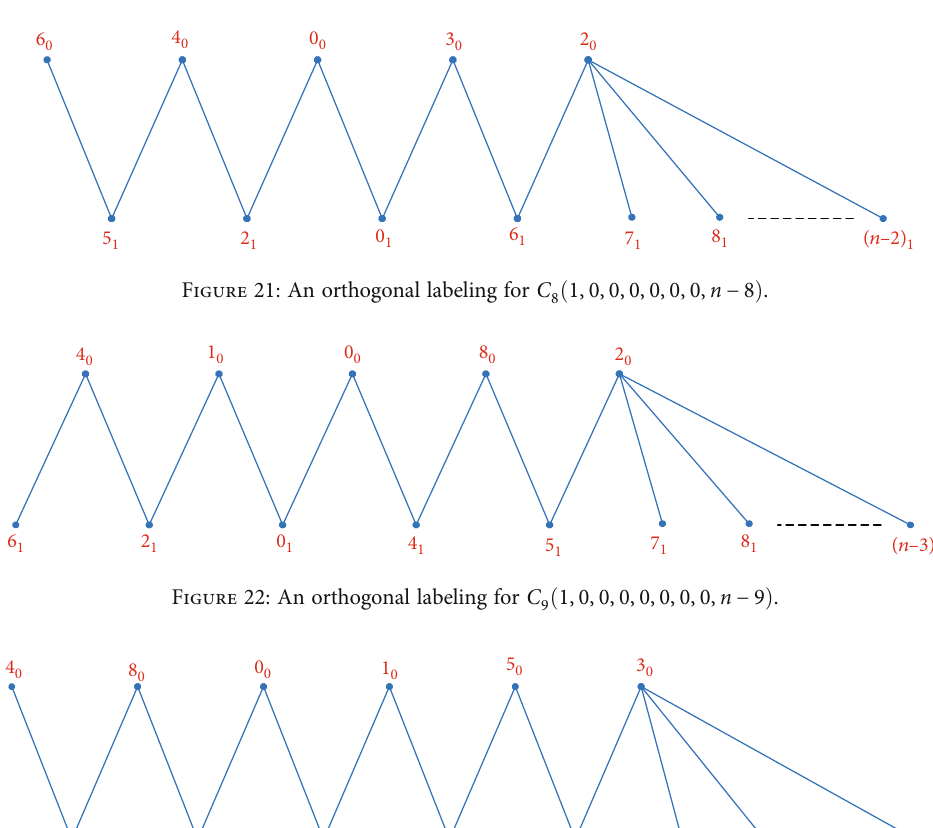
ð 1, 0, 0, 0, 0, 0, 0, 0, 0, n − 10 Þ 10